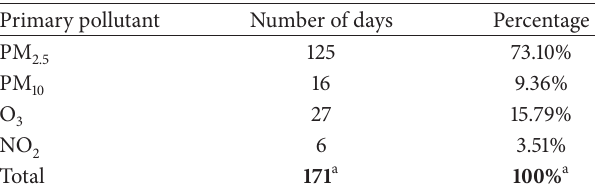
to the nonattainment rates of the 2.5